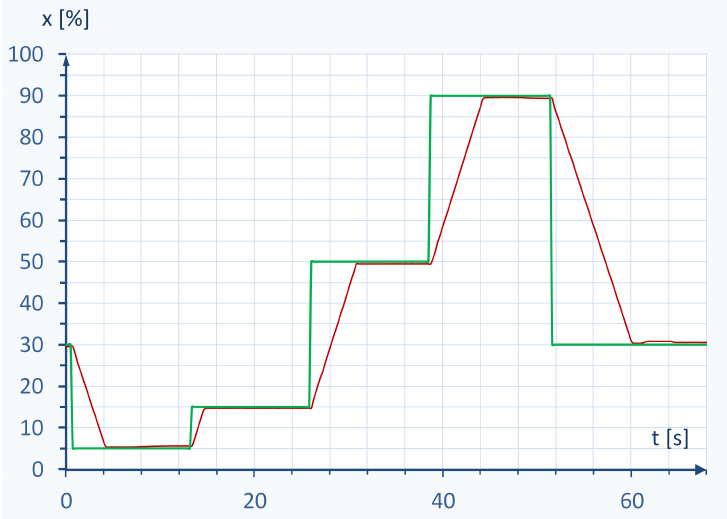
Figure 20. Illustration of the autotuner quality on the stepwise response of reverse-action actuator type R-400 from Polna S.A. The applied nominal bench range is [80–240 kPa]. The nominal supply pressure, p s , is 400 kPa. SP —green line, PV —red line. Parameters: k p = 9.6; T i = 61 s, T d = 0.07 s; T r = 15.2 s. Here, we can observe an aperiodic response and close to zero steady-state